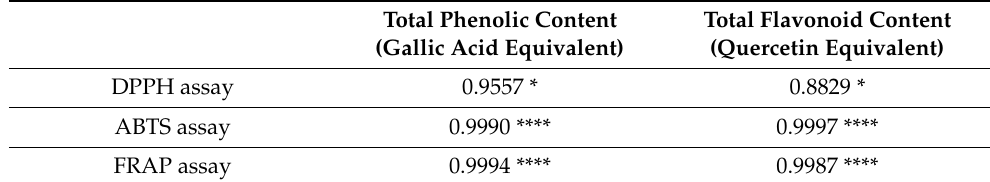
Table 4. Pearson correlation coefficients of total phenolic and flavonoid contents and antioxidant activities of C. chinense leaf ethanolic extract measured by DPPH, ABTS, and FRAP assays. Total Phenolic Content Total Flavonoid Content (Gallic Acid Equivalent) (Quercetin Equivalent) DPPH assay 0.9557 * 0.8829 * ABTS assay 0.9990 **** 0.9997 **** FRAP assay 0.9994 **** 0.9987